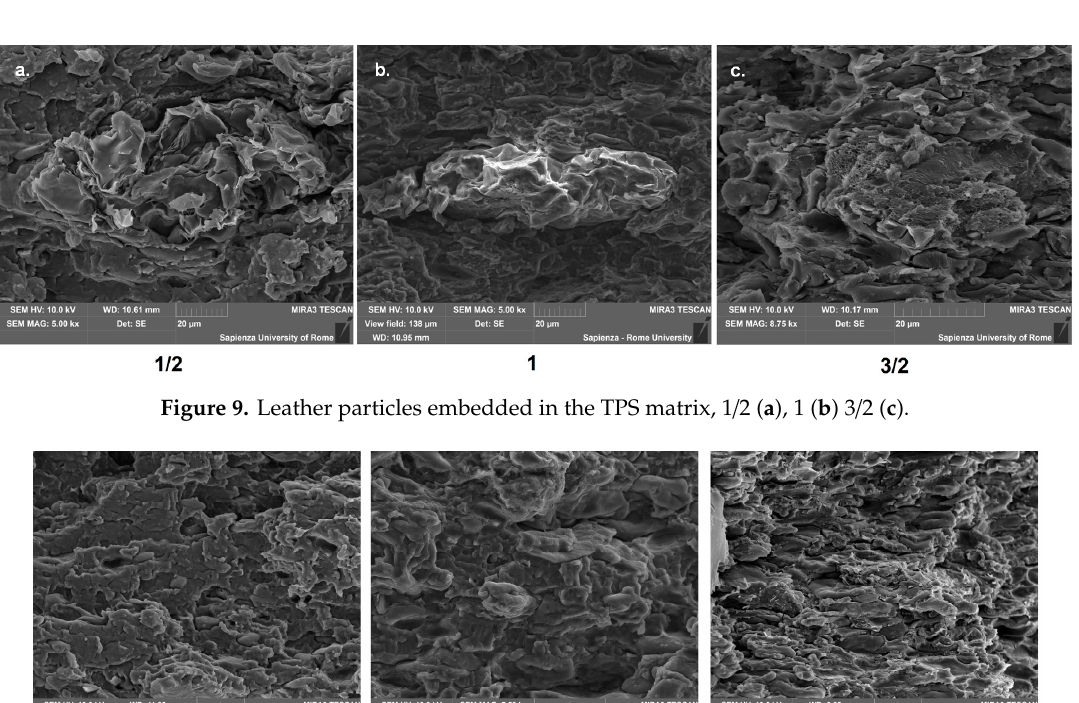
Figure 8. Fracture surface of the composite, without ( a ) and with ( b ) pulled-out leather particles at failure.